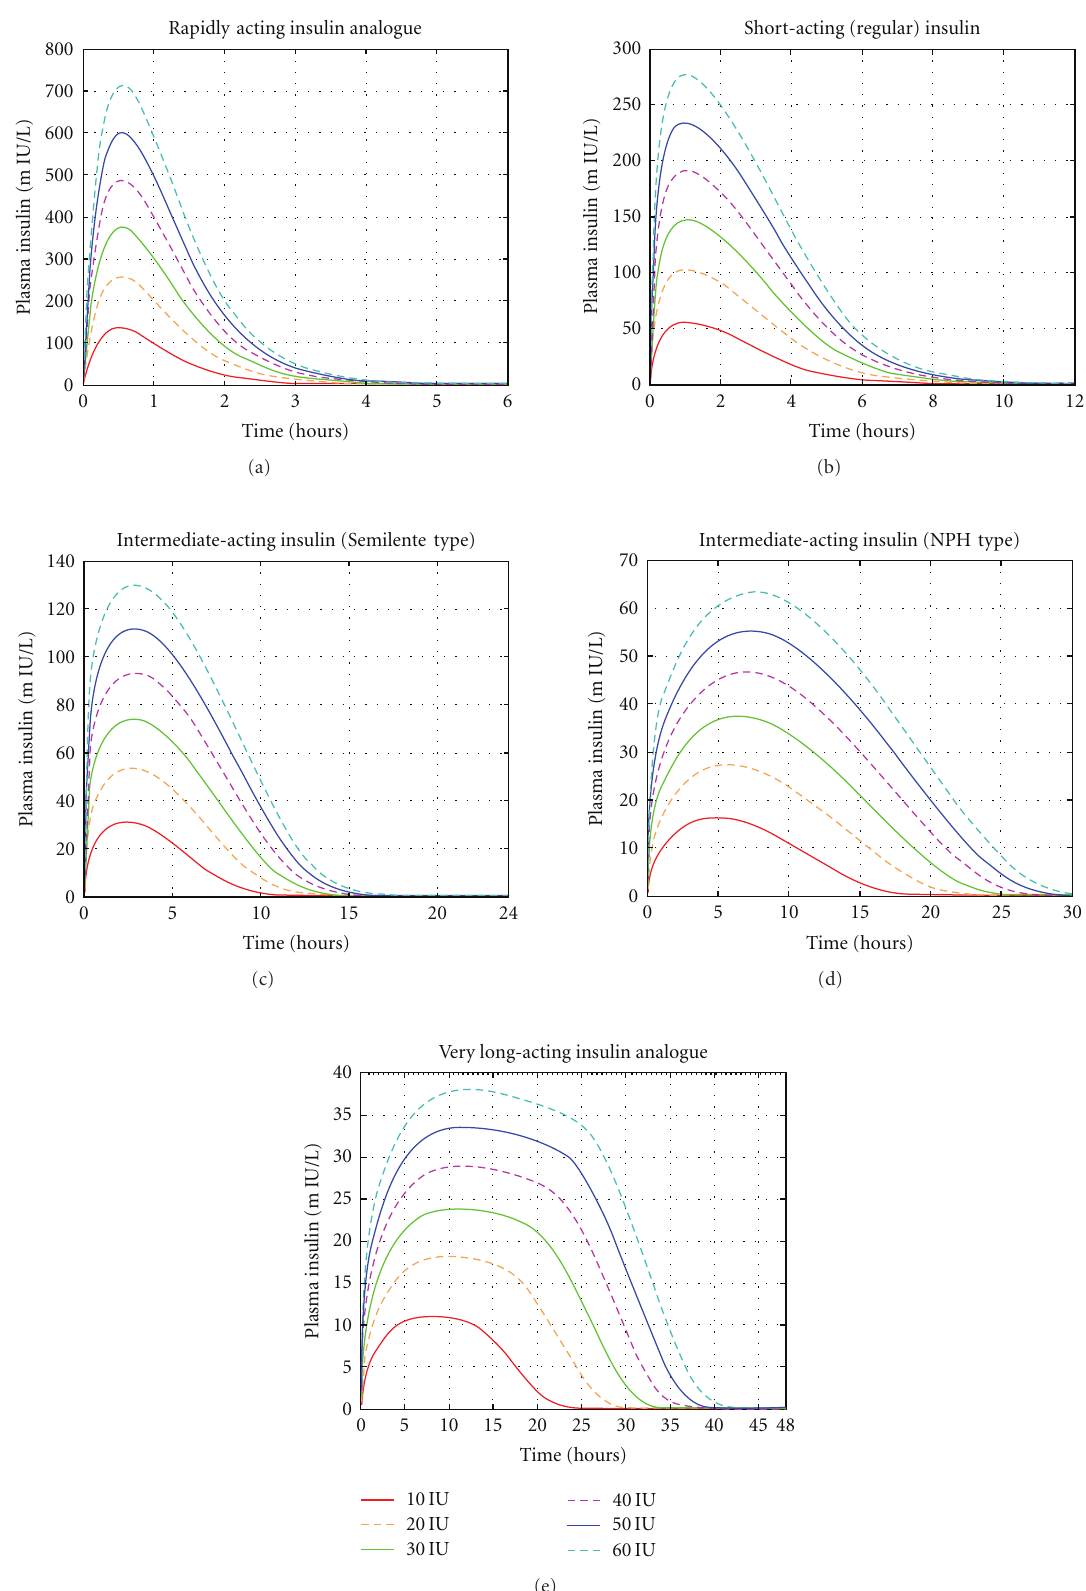
Figure 7: Plasma insulin simulations following subcutaneous injections of (a) a rapidly acting insulin analogue (such as lispro/Humalog or aspart/NovoLog), (b) a short-acting (regular) insulin preparation (e.g., Actrapid), intermediate-acting insulin (both (c) Semilente and (d) NPH types), and (e) a very long-acting insulin analogue (such as glargine/Lantus) for injected insulin doses up to 60 units of